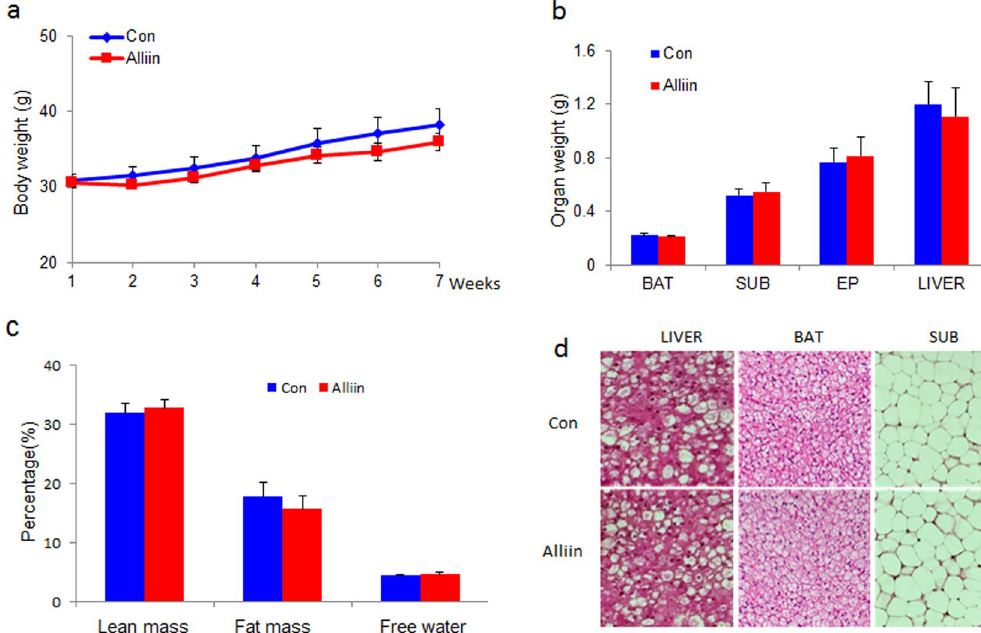
Figure 3. Alliin has no significant effect on body weight, organ weight or fat mass in DIO mass. ( a , b and c ) No significant difference of body weight, organ weight or fat content was found between alliin treated or control mice. ( d ) HE staining showed a similar tissue structure of liver, BAT and subcutaneous fat mass between alliin treated and the control mice. Representative pictures were shown. Data are means ± SEM (n = 6). BAT, brown adipose tissue; SUB, subcutaneous fat. BAT, brown adipose tissue; SUB, subcutaneous fat; EP, epididymal